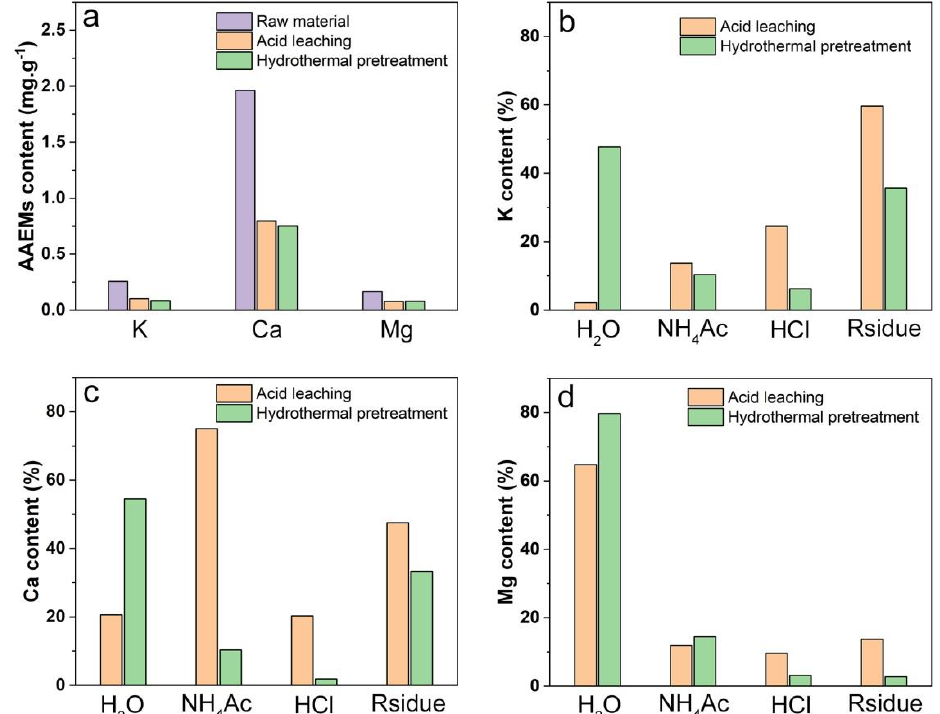
Figure 5. Forms of main metal elements in eucalyptus before and after hydrothermal pretreatment and acid leaching (( a ), contents of K, Ca and Mg in different eucalyptus samples. ( b ), contents of K in different forms in eucalyptus after acid pickling and hydrothermal pretreatment. ( c ), contents of Ca in different forms in eucalyptus after acid pickling and hydrothermal pretreatment. ( d ), contents of Mg in different forms in eucalyptus after acid pickling and hydrothermal pretreatment).